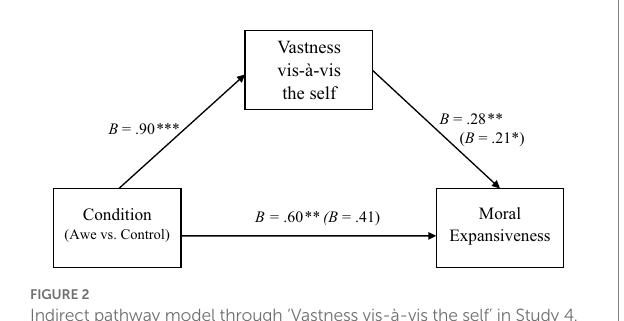
FIGURE 2 Indirect pathway model through ‘Vastness vis-à-vis the self’ in Study 4. N = 125. Predictor variable condition is binary (Awe = 1, Control = 0). Unstandardized coefficients are displayed. Numbers in parentheses indicate coefficients when condition is predicting moral expansiveness while controlling for ‘vastness vis-à-vis the self.’ * p < .05, ** p < .01, *** p <